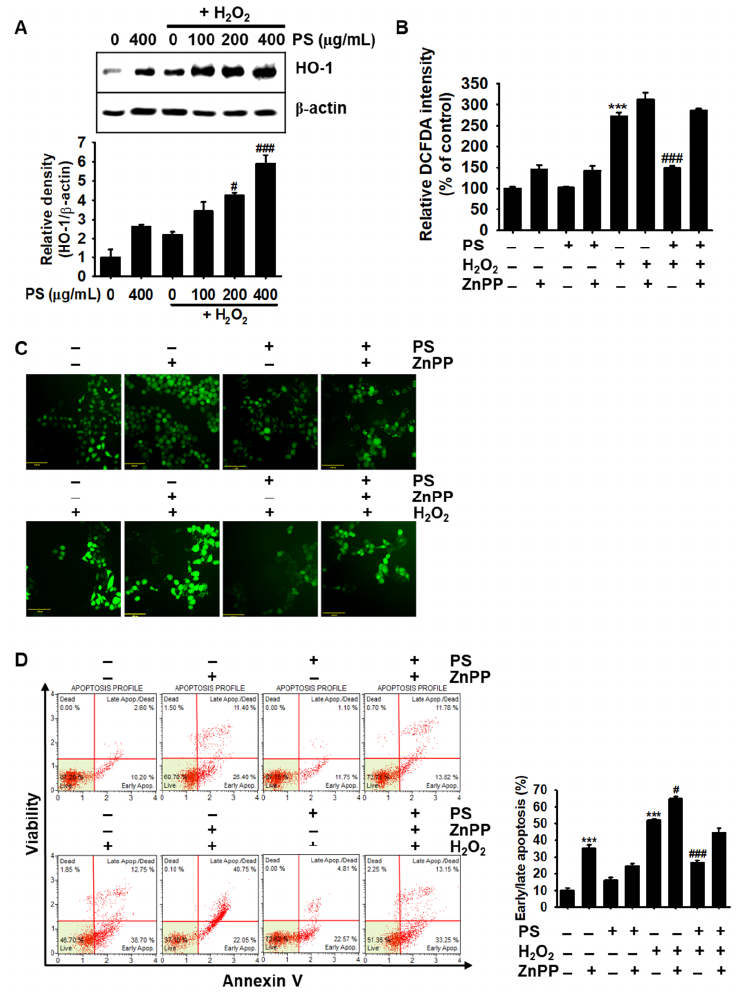
Figure 7. PS protects HaCaT keratinocytes from H 2 O 2 -mediated oxidative stress by activating HO-1. ( A ) HaCaT keratinocytes were seeded at a density of 1 × 10 4 cells/mL and treated with the indicated concentrations of PS (0–400 µ g / mL) for 20 h before treatment with 1000 µ M H 2 O 2 for 4 h.